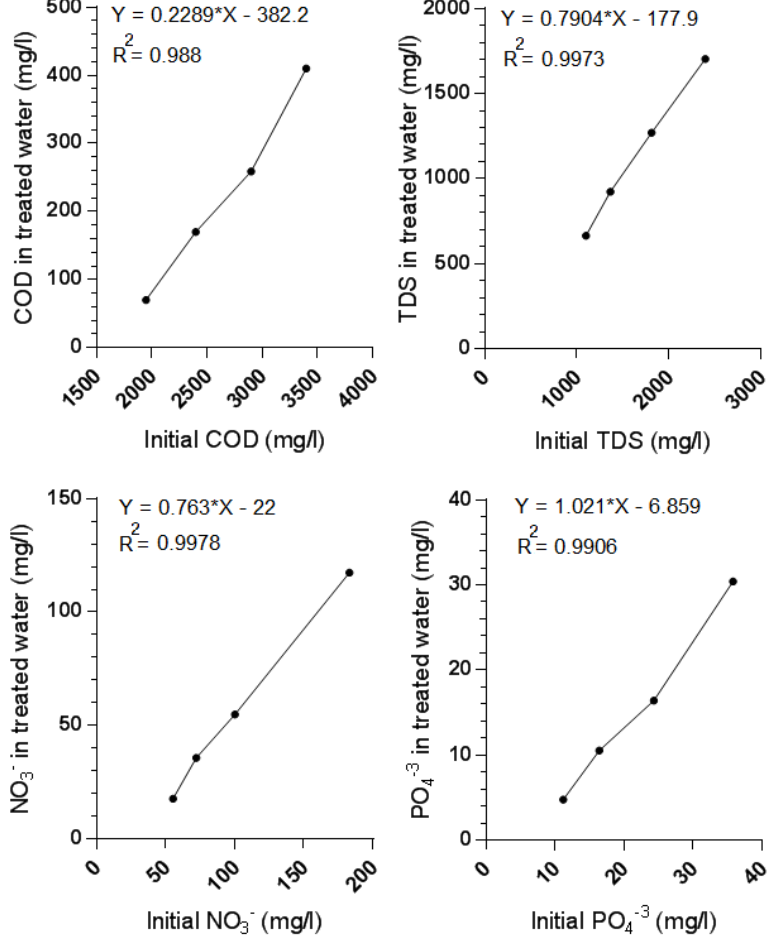
Figure 4. MBBR system regression analysis between influent and effluent quality under constant hydraulic retention time (HRT) of 6 h and for different biochemical